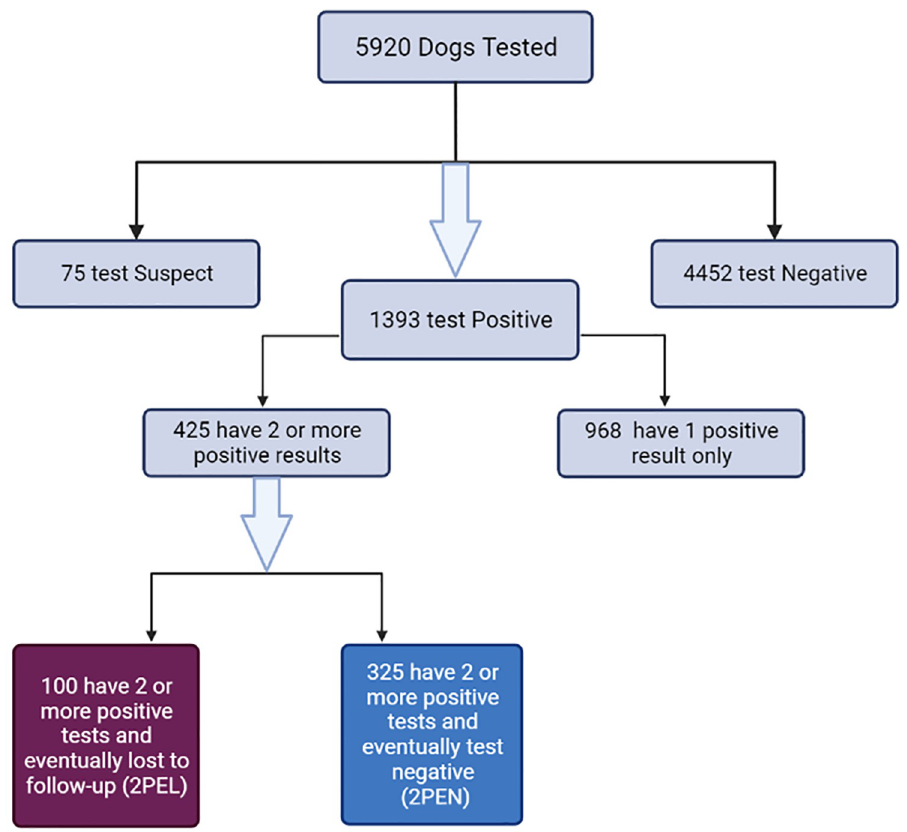
Fig 1. Organizational chart for RT-PCR testing in shelter dogs. 2PEL = 2 positive eventually lost; 2PEN = 2 positive eventually negative. Created with BioRender.com.